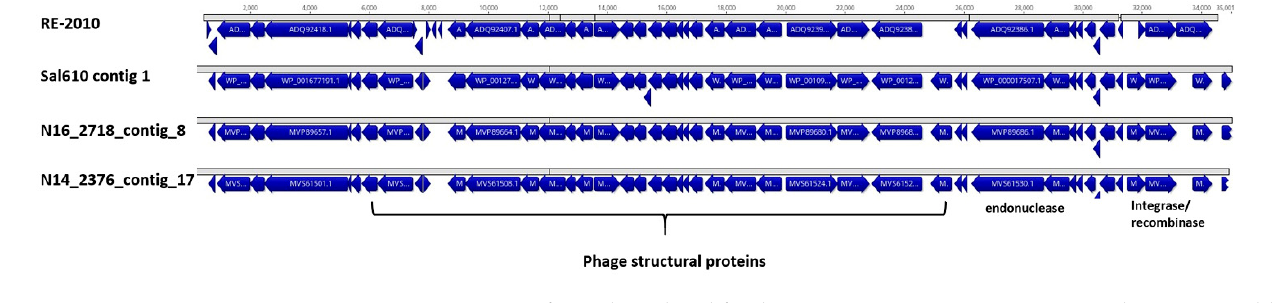
Figure 6. ST377 strains from clinical and food sources contain a unique S . Enteriditis RE-2010-like phage. An ELPhiS prophage RE-2010 (Accession: HM770079) from S. Enteriditis LK5 [59] was identified in ST377 genomes. A comparison of representative genomes from three strains isolated from different sample sources are illustrated above: Sal610 contig 1 (AZKX01000024)—Clinical, N16_2718_contig_8 (WSCE01000008)—Clinical and N14_2376_contig_17 (WSDY01000017)—Food, Onion. The S. Bovismorbificans version of the phage appeared to be homologous with predicted additional ORFs in the structure protein core. Prevalence of other phage sequences in S. Bovismorbificans strains from this study are listed in the Supplemental File S5. Table 2. Antimicrobial resistance genes identified in the S. Bovismorbificans genomes a .